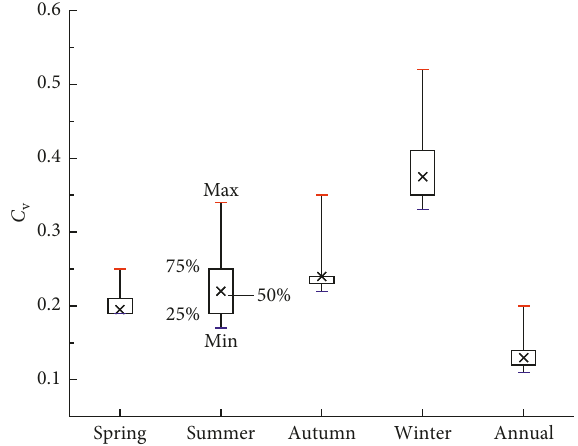
Figure 3: Box diagram of C v at 6 stations in UMR from 1960–2015.